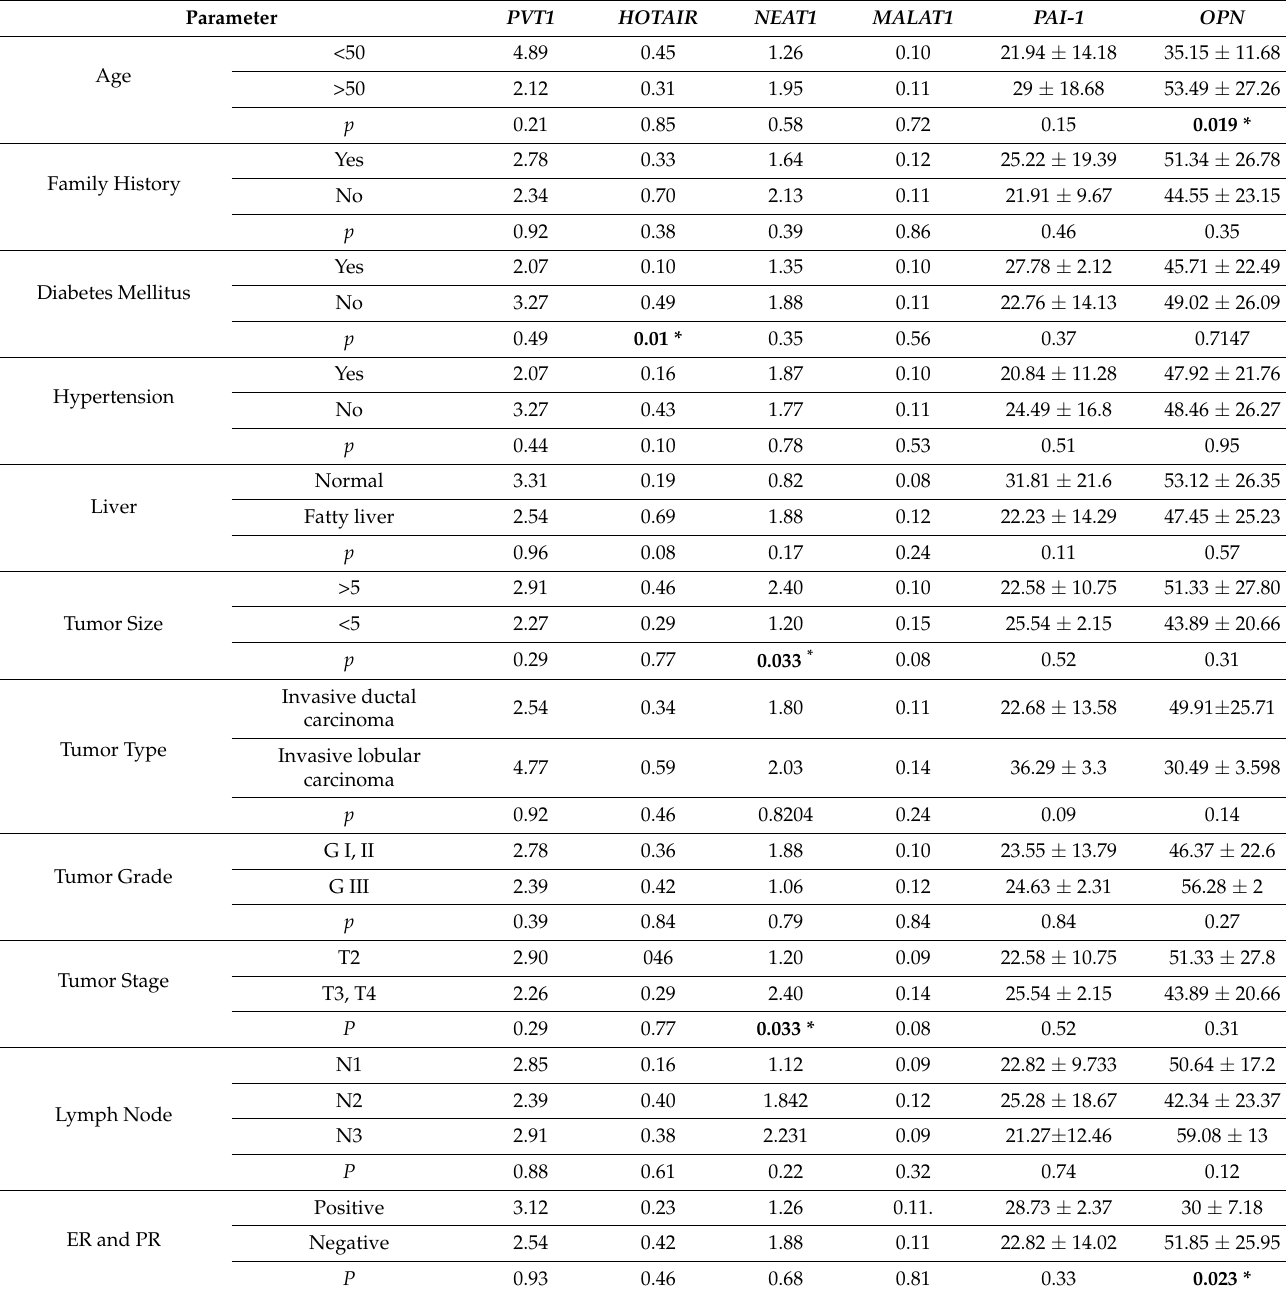
Table 4. Relationship between serum expression levels of PVT1, HOTAIR, NEAT1, MALAT1, PAI-1, and OPN, and the clinicopathological characteristics in breast cancer